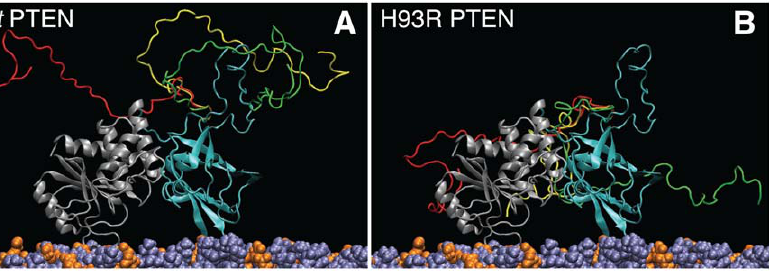
Figure 5. Schematic Depiction of the PTEN Phosphatase on the Surface of a Thermally Disordered stBLM. Peptide backbone representation of (A) wt PTEN and (B) H93R PTEN positioned at a DOPC/DOPS (7:3) membrane surface as deducted from the NR results. The membrane-associated protein penetrates the lipid headgroups (PC: violet, PS: orange) only barely. The PTEN core domains (PD: magenta, C2: grey) are shown in a conformation and membrane orientation deduced from the crystal structure [24]. The close correspondence, observed in Fig. 4, between the nSLD distribution across the interface determined in this work and the nSLD distribution of the truncated PTEN computed from the crystal structure suggests that this is a good approximation. Moreover, about 20% of the protein mass have been deleted in the truncated protein, and , 20% of the nSLD remains unaccounted for in the overall nSLD distribution for wt PTEN in Fig. 4A, if we position the PTEN core domains at the membrane as shown here. The C-terminal tail, which forms the bulk of the deleted peptide, is apparently quite different in its organization in wt and H93R PTEN at the membrane. Shown here in red, yellow and green are three distinct conformations, obtained from Monte-Carlo simulations [57], on each PTEN protein core that are consistent with the observed nSLD distributions shown in Figs. 4A and